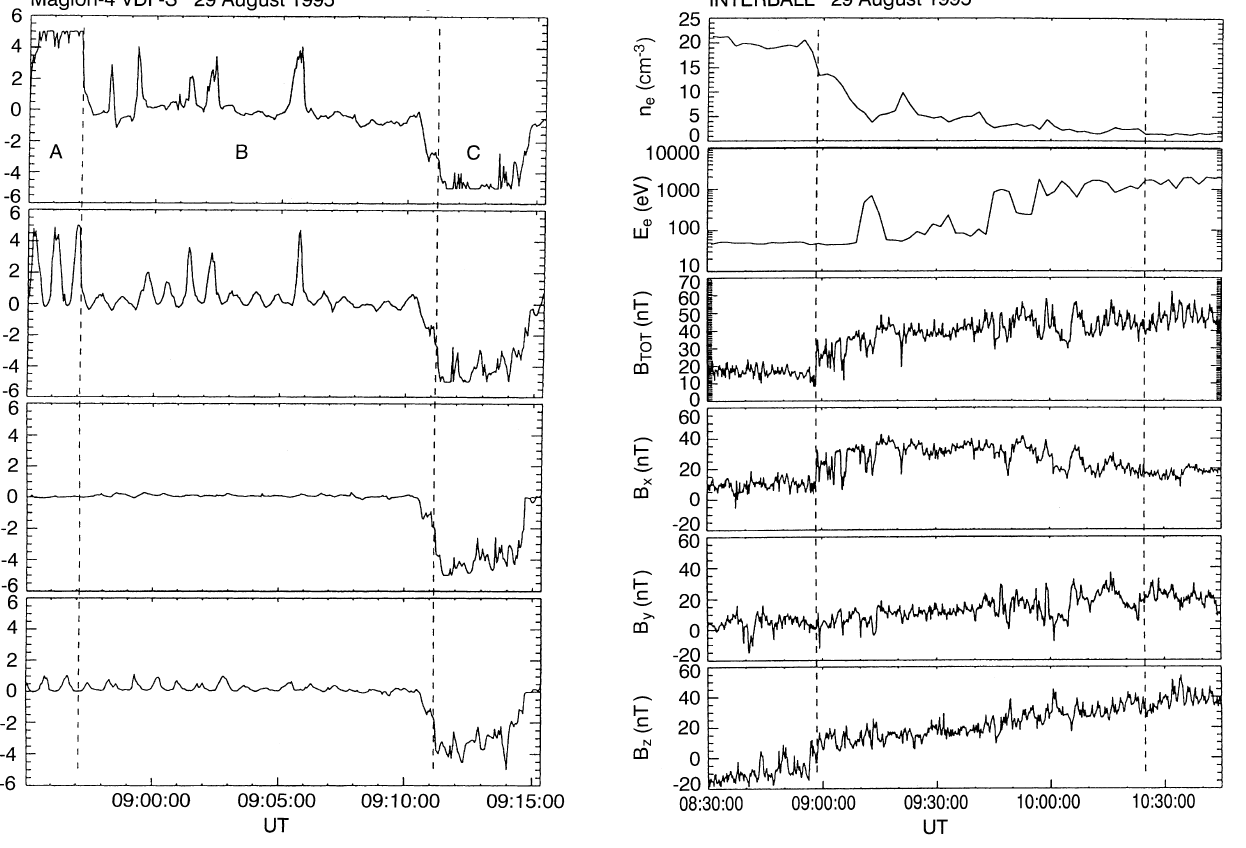
Fig. 8. Faraday’s cup currents during the same event as in Fig. 6 Fig. 9. Overall view of the magnetopause crossing as measured by INTERBALL-1 satellite. The dashed lines denote the magnetopause (left) and the inner edge of the